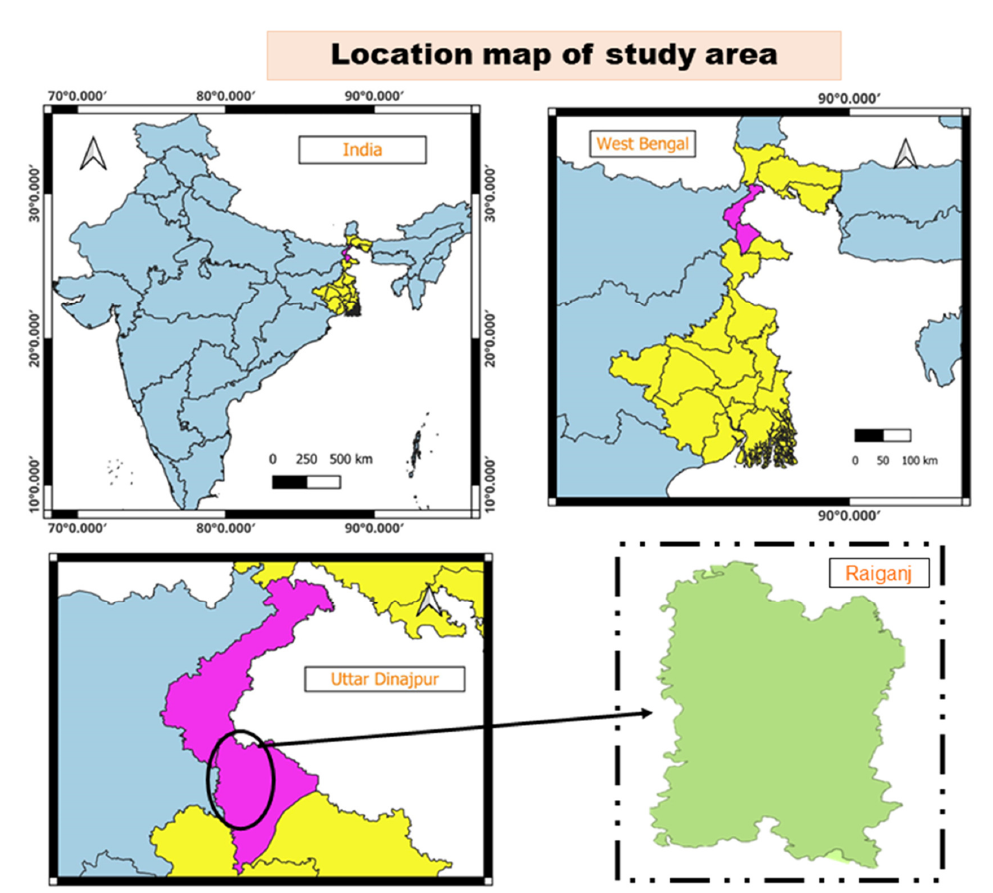
Figure 1. Study area map of Kulik forest, Raiganj, Uttar Dinajpur, West Bengal, India Identification of selected bacterial